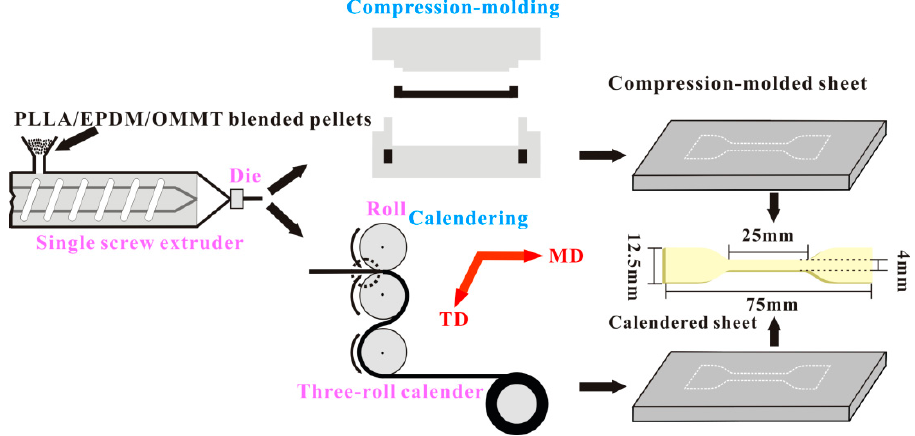
Figure 1. Schematic illustration of calendering process and compression–molding process.